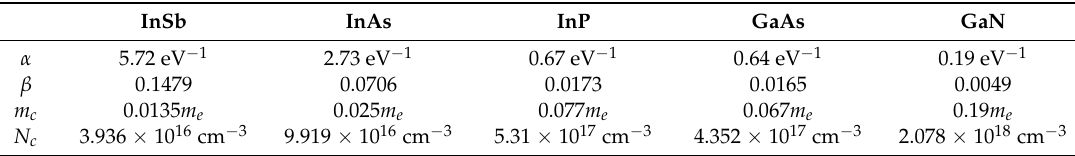
Table 1. Material parameter values used for the calculation of the D / µ ratios for conduction electrons at T L = 300